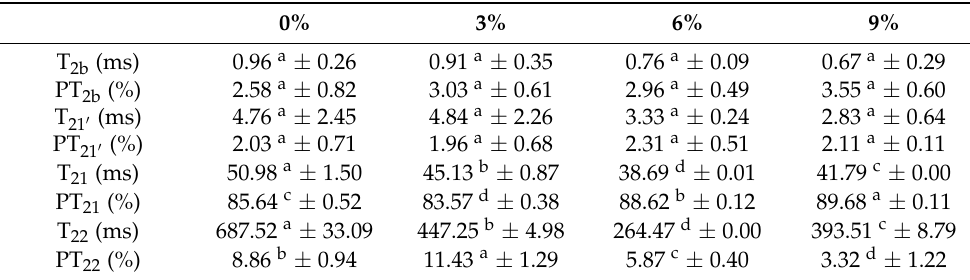
Table 2. The relaxation times and corresponding peak areas of duck meat batters with the addition of the pea protein (0%, 3%, 6% and